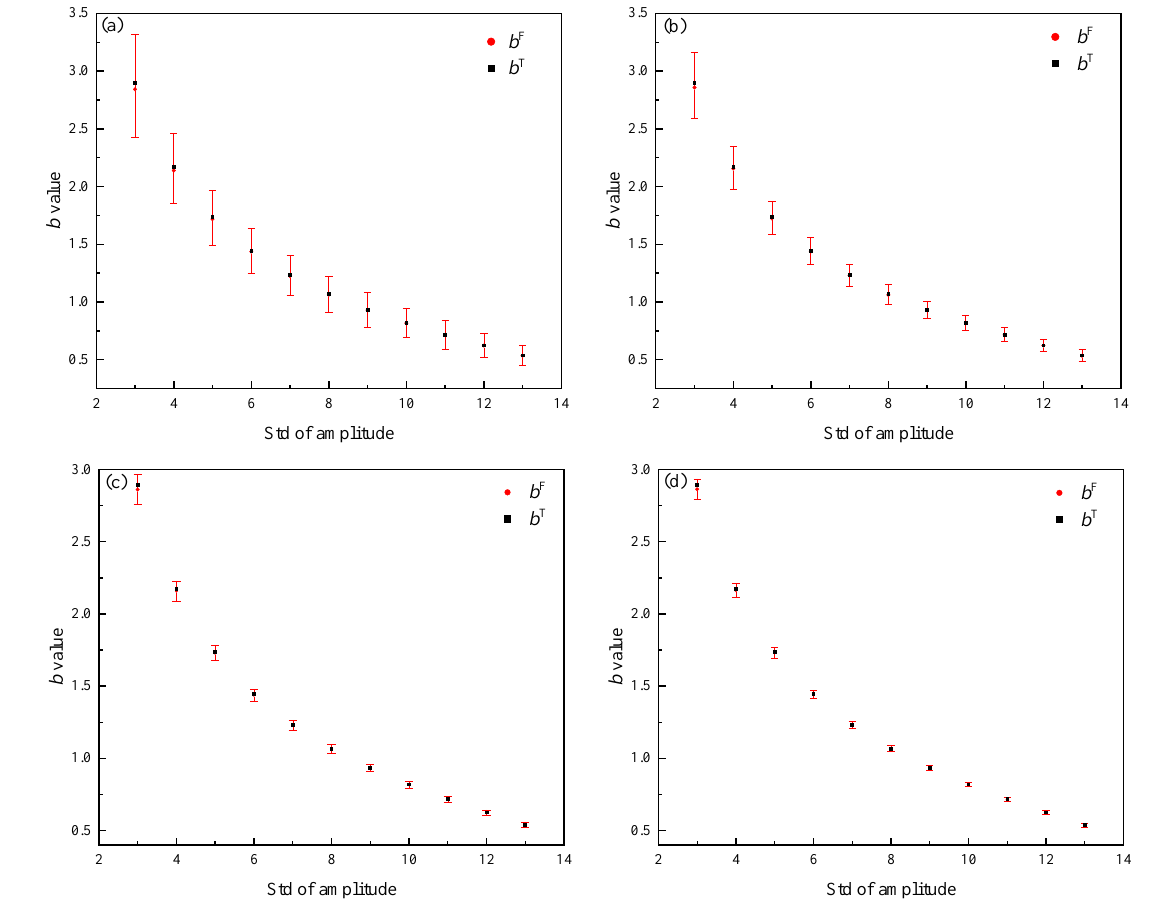
Figure 1. The b F and corresponding confidence limits with different b T . ( a – d ) are the b T , b F and confidence limits when the data volume is 5000, 10,000, 50,000 and 100,000, respectively. The abscissa “ Std of amplitude ” is the set standard deviation value when the computer generates amplitude data of different b T (here, we generate the data sets at 11 standard deviation values). Red color bars are the corresponding confidence limits of b F .